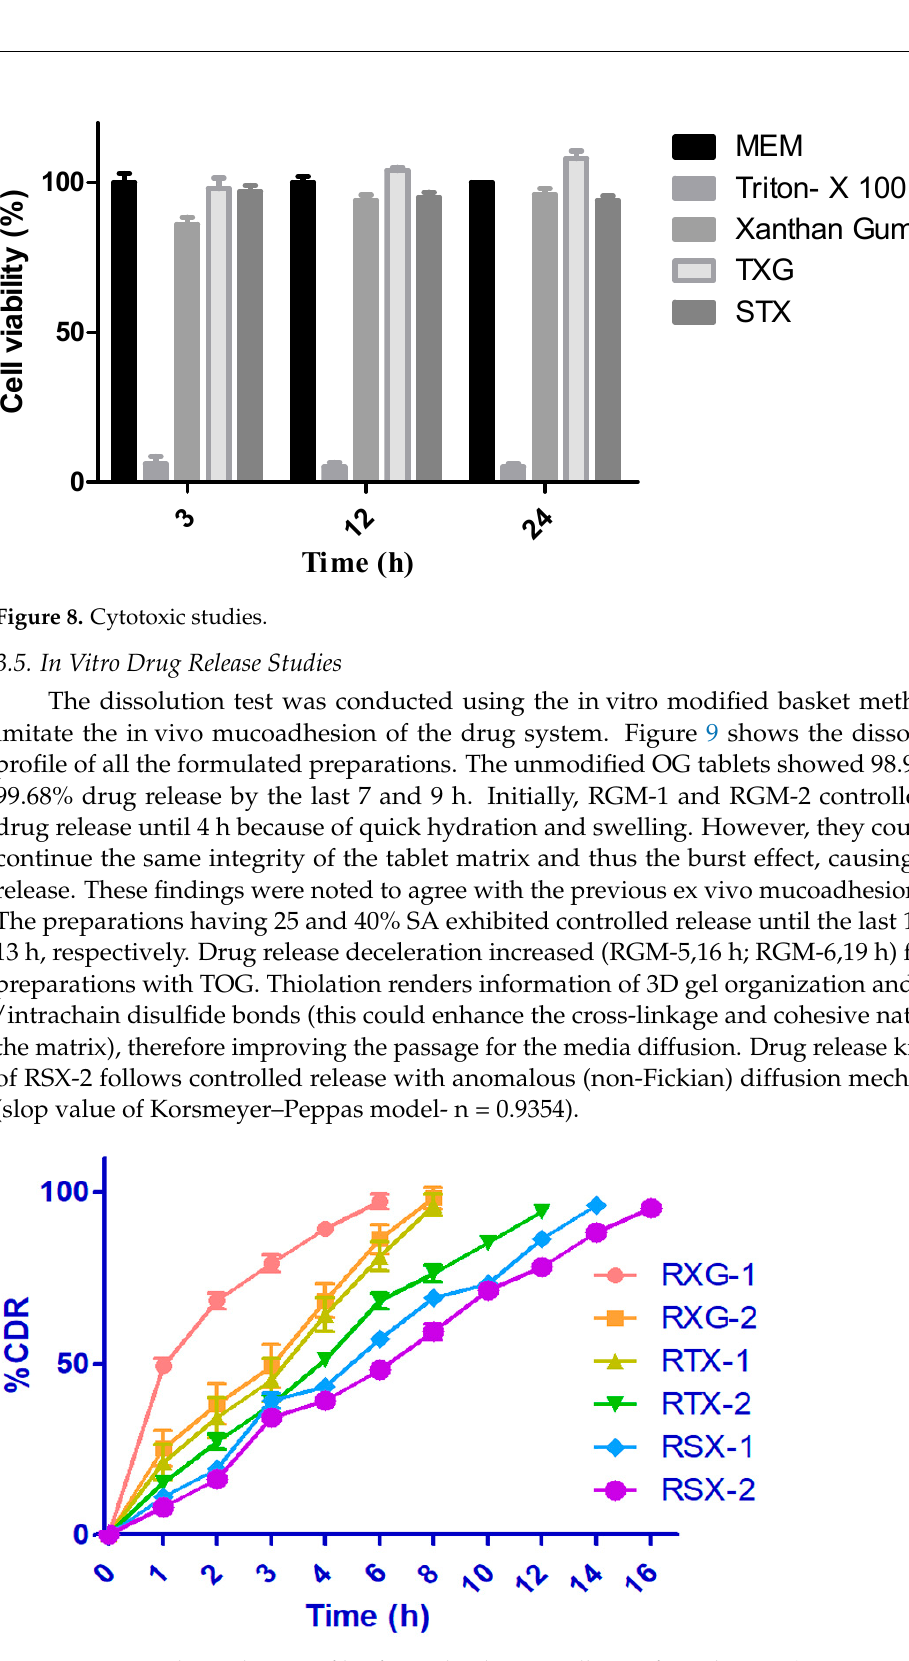
Figure 9. In vitro drug release profile of repaglinide mucoadhesive formulations. (CDR—cumulative drug release.)